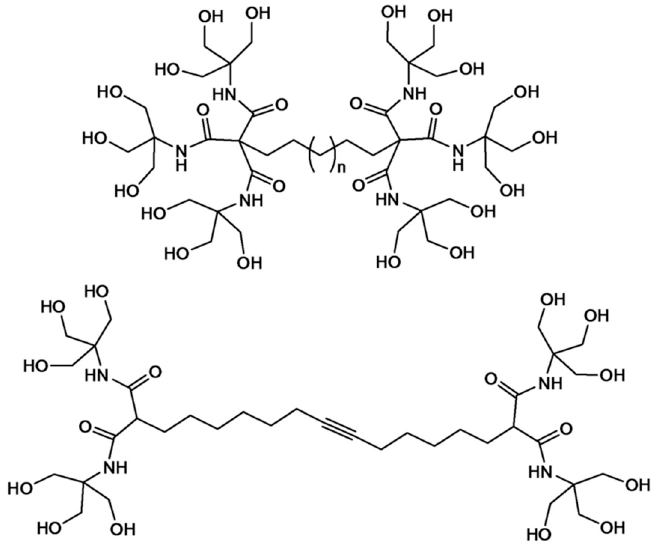
Figure 1. Gel-forming bolaamphiphiles. Adapted with permission from [10], Copyright © 1997 American Chemical Society.